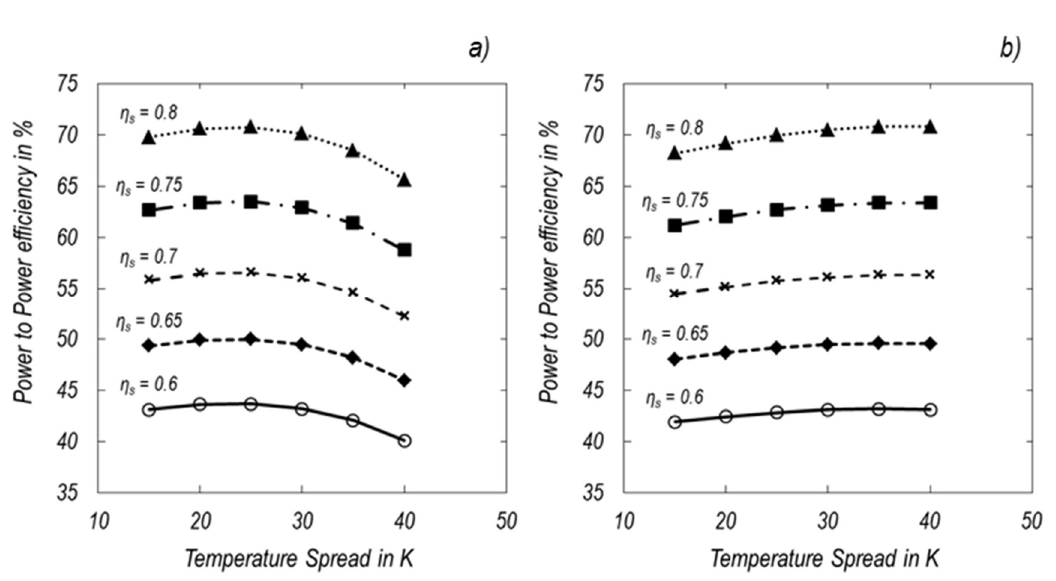
Figure 11. Impact of isentropic efficiencies of the heat pump’s compressor and the Rankine cycle’s expander on the system’s power-to-power efficiency for an upper storage temperature level of 140 °C (( a ) single stage process; ( b ) two stage process).